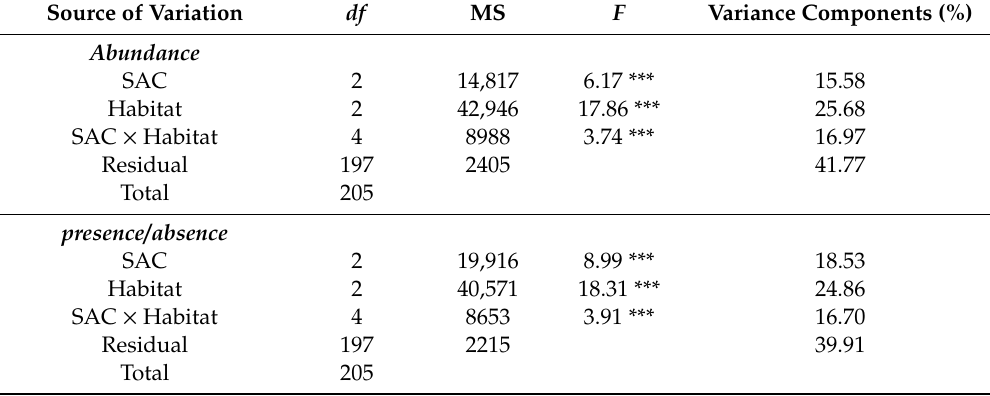
Table 3. PERMANOVA results on percentage cover of species and occurrence data in 206 dune plots. SAC—Special Areas of Conservation. The main e ff ects and their interactions were tested separately under a null model. *** p ≤